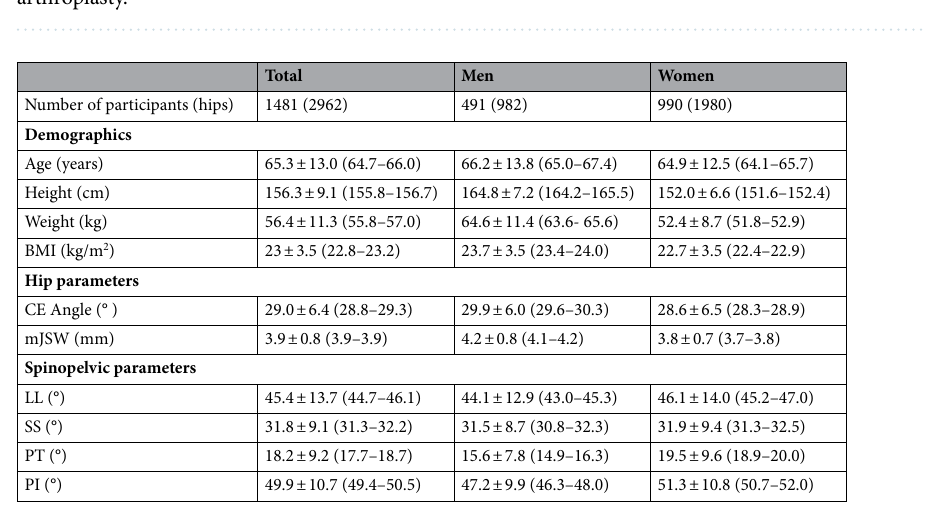
Table 5. Characteristics of the participants. Data are means ± standard deviation (95% confidence interval of the mean). Hip parameters were calculated from 2962 hips. BMI body mass index, LL lumbar lordosis, S sacral slope, PT pelvic tilt, PI pelvic